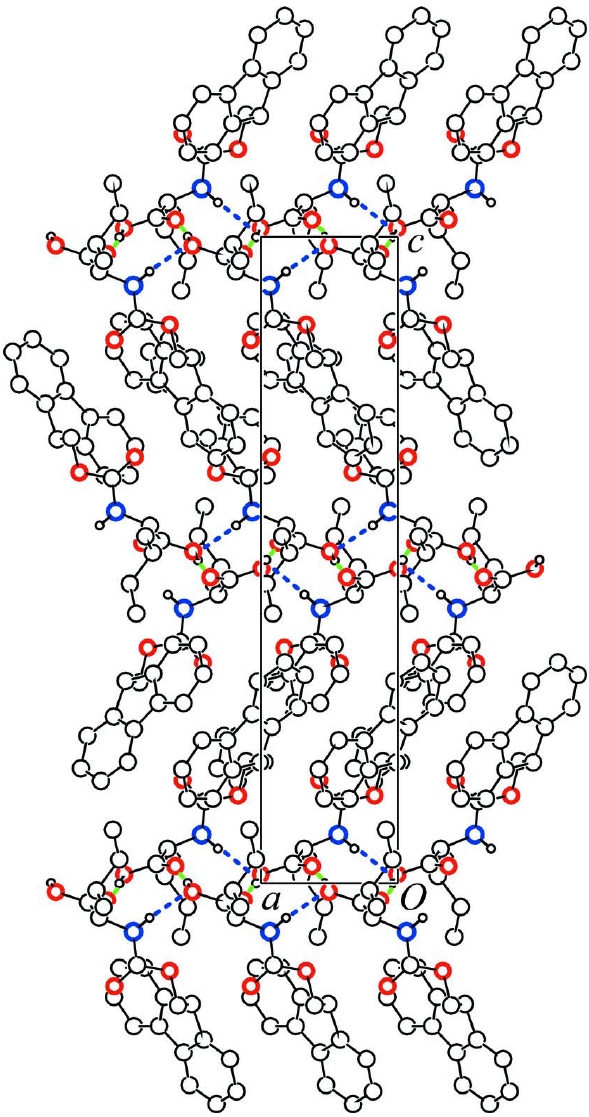
A packing diagram of (I). The hydrogen atoms were omitted for clarity, except for those forming the hydrogen bonds. The hydrogen bonds are shown as blue and green broken lines for N—H···O and O—H···O bonds,